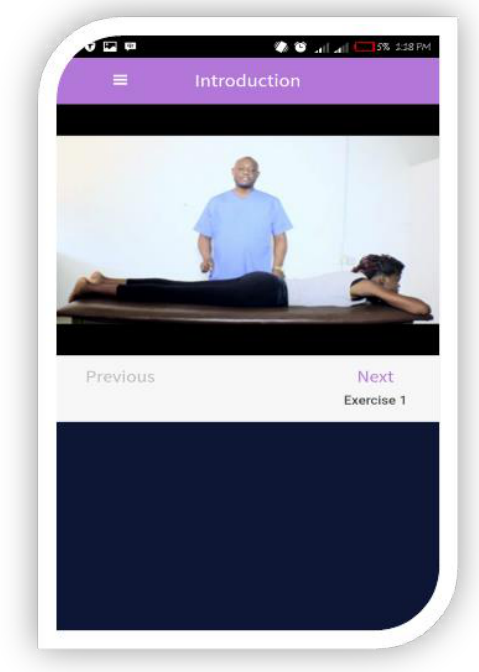
Figure 3. McKenzie extension exercise start